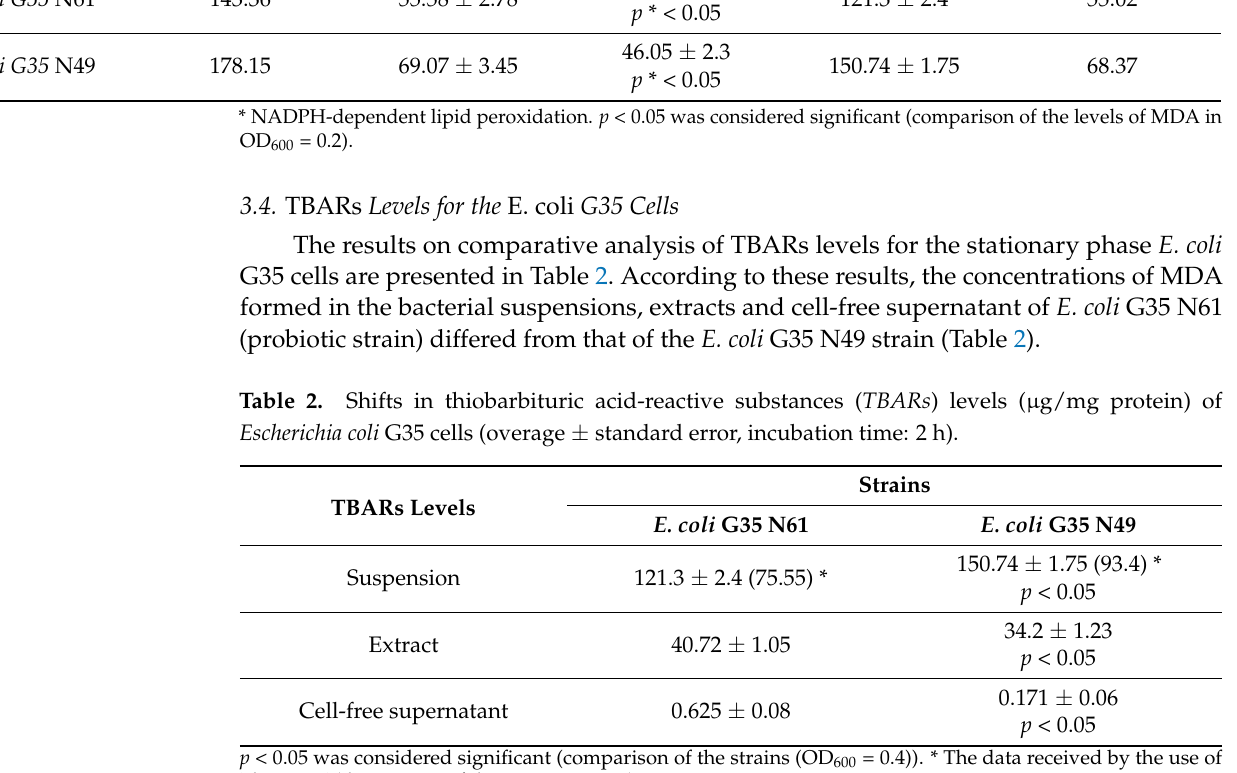
Table 1. Impact of growth phase on thiobarbituric acid-reactive substances (TBARs) levels * in cell suspension of Escherichia coli , µ g/mg protein (overage ± standard error, incubation time: 2 h). Logarithmic Phase of Growth Stationary Phase of Growth Strains OD 600 = 0.1